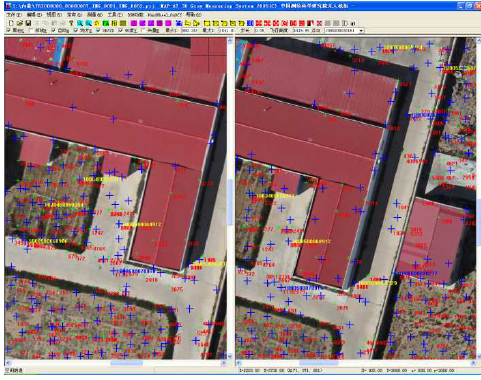
Figure 4 MAP-AT aerial triangulation